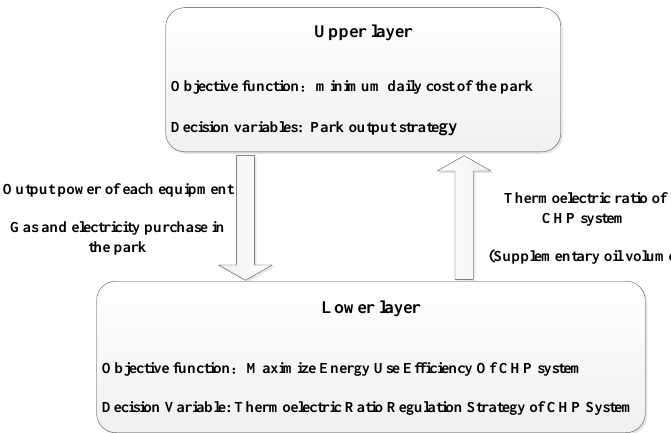
Figure 2. Double-layer optimal scheduling model.